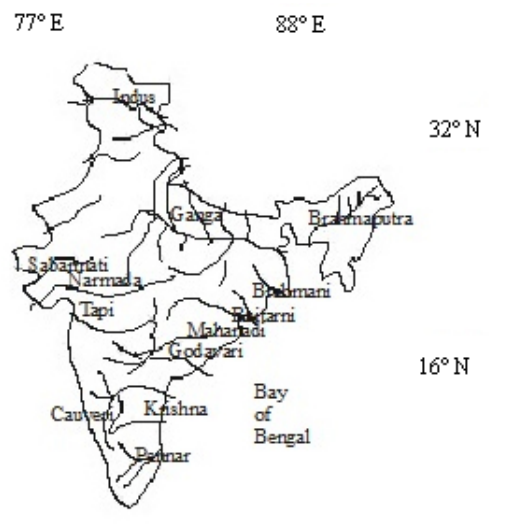
Figure 1. India – Major river